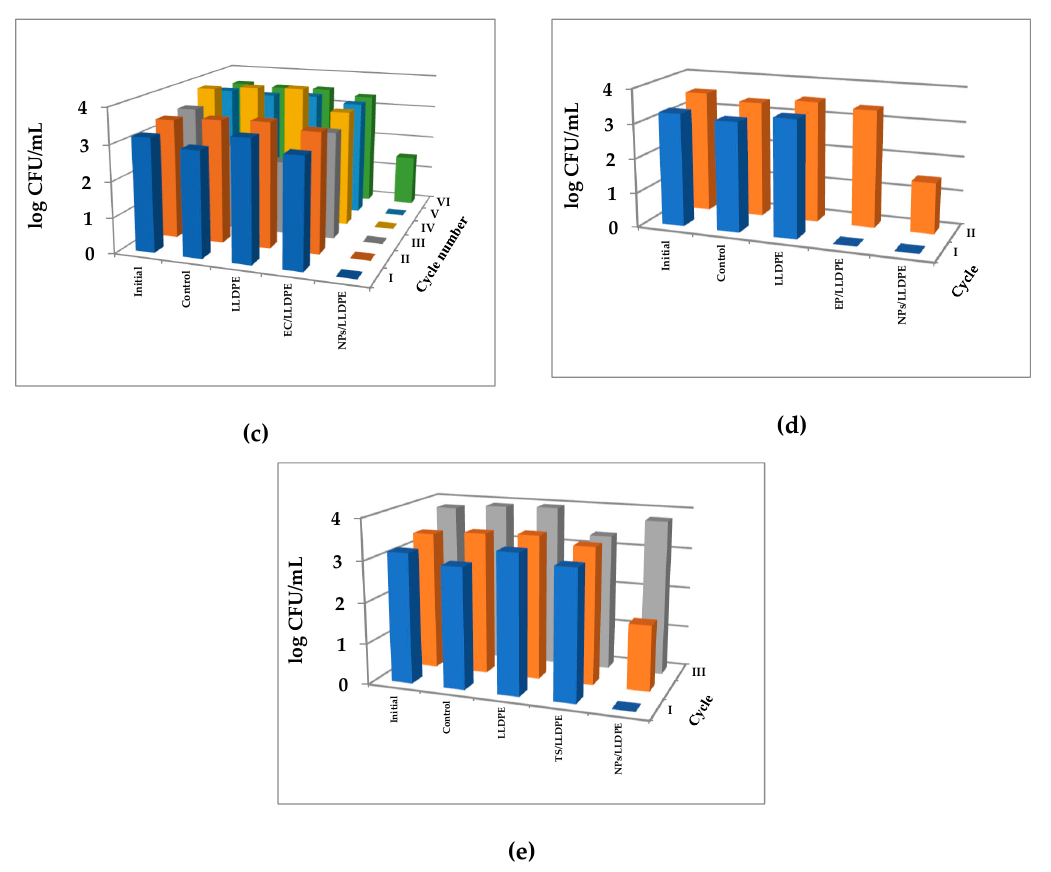
Figure 6. Activity of the Cu 2 ONPs-LLDPE composites against S. aureus cells of composites obtained by: ( a ) extrusion; ( b ) thermal adhesion; ( c ) using ethyl cyanoacrylate; ( d ) using epoxy resin; ( e ) using trimethoxyvinylsilane. Roman figures show the number of re-use cycles. Initial— S. aureus cells before the incubation, control— S. aureus cells after 30 min incubation, LLDPE— S. aureus cells after 30 min incubation with LLDPE, EC/LLDPE— S. aureus cells after 30 min incubation with LLDPE coated with with a trimethoxyvinylsilane layer, EP/LLDPE— S. aureus cells after 30 min incubation with LLDPE